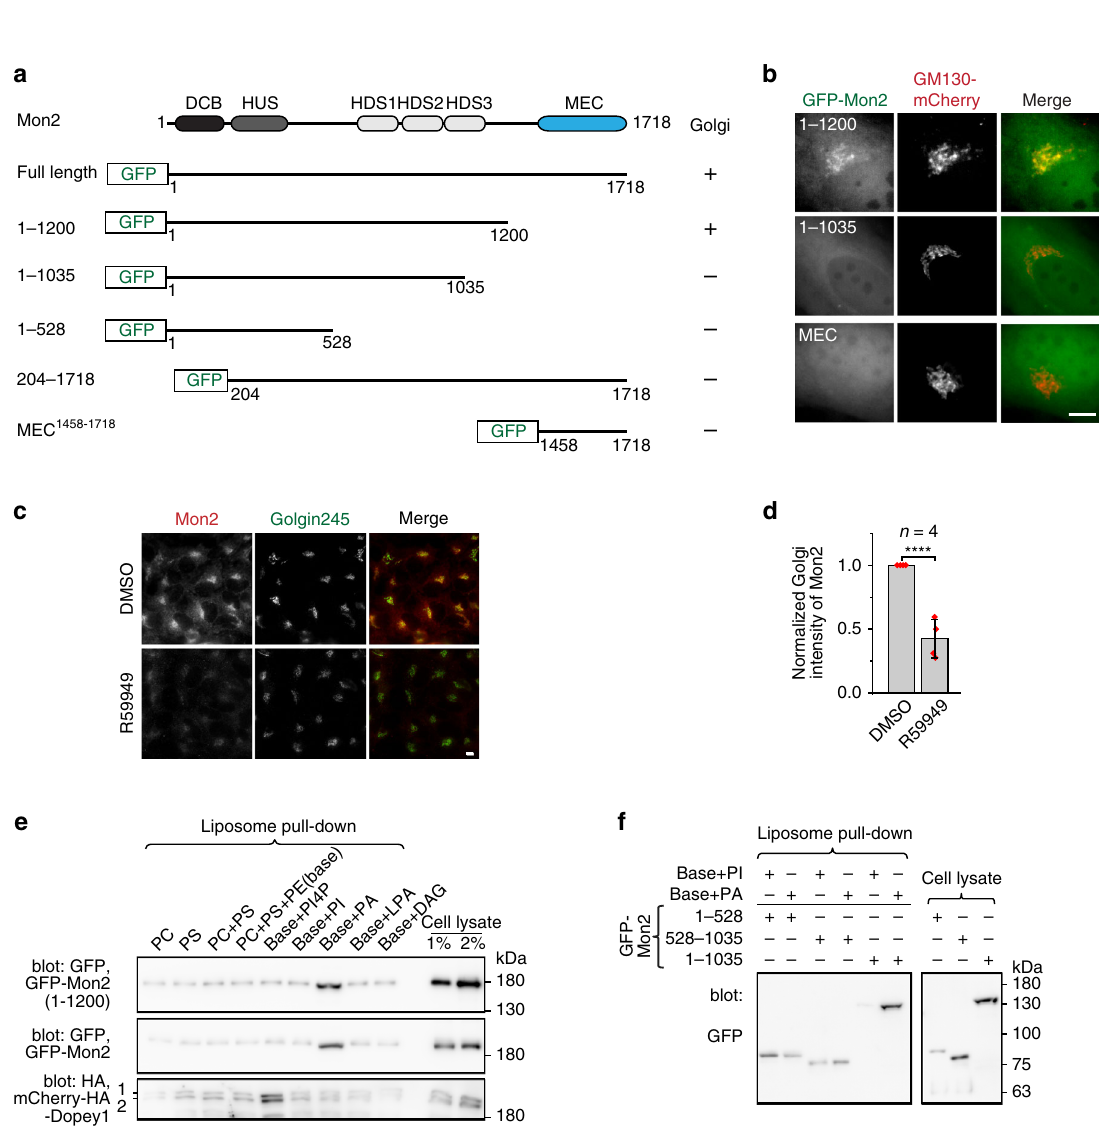
Fig. 3 Dopey1 speci fi cally and directly interacts with PI4P. a – f The Golgi localization of Dopey1 and DEC, but not Mon2, is sensitive to PAO treatment. GFP- tdDEC transfected ( a , b ) or untransfected cells ( c – f ) were treated with 10 µ M PAO followed by staining of indicated proteins. Dotted white lines demonstrate cell contours ( c , e ). In b , d , and f , the normalized Golgi intensity per cell was plotted against the time below the corresponding panel; error bar indicates mean ± s.e.m; n is the number of cells analyzed; results are representatives of three independent experiments. g , h The Golgi localization of Dopey1, but not Mon2, decreases upon the depletion of PI4KIII β . Indicated shRNAs were expressed using lentivirus and cells were stained for indicated proteins. The normalized Golgi intensity per cell is plotted at the right. Red dot, individual data point; error bar, mean ± s.d. from n = 3 independent experiments. i – m Dopey1 and DEC speci fi cally interact with PI4P. Liposomes with 10% (m/m) indicated phosphoinositides were incubated with either the cell lysate expressing indicated fusion protein(s) ( i – l ) or puri fi ed recombinant protein ( m ). Proteins pulled down were analyzed by immunoblotting using indicated antibody. n , o Dimerized Dopey1 does not require Mon2 for its Golgi localization. Cells were subjected to control or Mon2 knockdown followed by transient expression of indicated construct. Endogenous Golgin97 (a Golgi marker) ( n ) or Golgin245 ( o ) was stained. Scale bar, 10 µ m. Molecular weights (in kDa) are labeled in all gel blots. HeLa cells were used in ( a – h , n , o ), while HEK293T cells were used in ( i – l ). P values are from t test (unpaired and two-